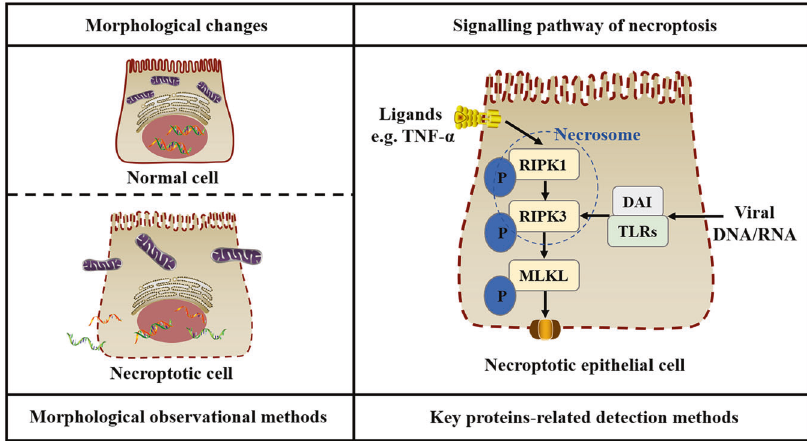
Fig. 1 Main detection methods of necroptosis. The left fi gure is a schematic diagram of the morphological changes in the necroptotic cell. The fi gure shows cellular swelling, organelle swelling, plasma membrane rupture, and cell lysis causing the release of the contents. Generally, it can be observed directly by an electron microscope. The right fi gure is a schematic diagram of the necroptotic signalling pathway. The fi gure shows RIPK1 phosphorylation upon receiving a signal from ligand binding and then RIPK3 activation, which interacts with RIPK1 to form a necrosome. Phosphorylated MLKL mediated by RIPK3 induces the formation of plasma membrane pores. In addition, DAI and TLRs can directly activate RIPK3 leading to necroptosis after detecting exogenous viral DNA or RNA. Key proteins in the necroptotic signalling pathway, such as RIPK3 and MLKL, can be detected by Western Blot, Immunohistochemistry or Enzyme-Linked Immunosorbent Assay. The expression levels of the genes corresponding to key proteins can be detected by Polymerase Chain Reaction. The above methods are suitable for detecting necroptosis. DAI DNA-dependent activator of interferon regulatory factors, MLKL mixed-lineage kinase domain-like, P phosphorylates, RIPK receptor-interacting protein kinase, TLRs toll-like receptors, TNF tumour necrosis